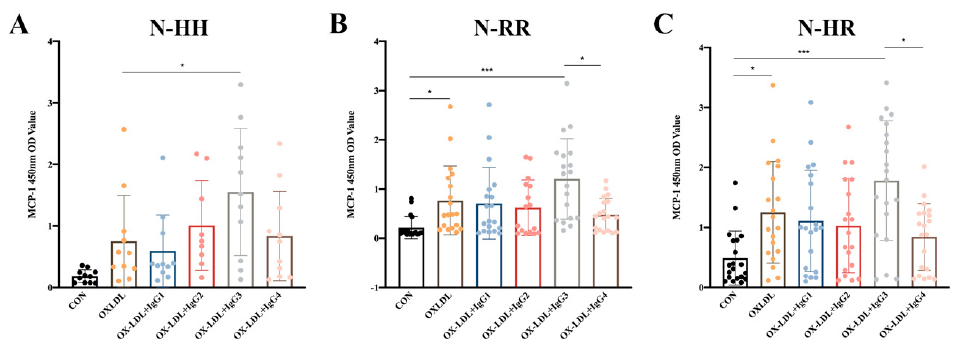
Figure 2. Effects of oxLDL and different isoforms of antibodies on MCP-1 release from human peripheral blood CD14 + monocytes. ( A ) Release of MCP-1 in Fc γ RIIA-131H/H normal individuals ( n = 11); ( B ) Release of MCP-1 in Fc γ RIIA-131R/R normal individuals ( n = 19); ( C ) Release of MCP-1 in Fc γ RIIA-131H/R normal individuals ( n = 20). Each ‘n’ number represents cells from PBMCs of a different patient. Data are expressed as mean ± SD. One-way ANOVA followed by Tukey’s multiple comparisons test for A-C, * p < 0.05, *** p < 0.001.